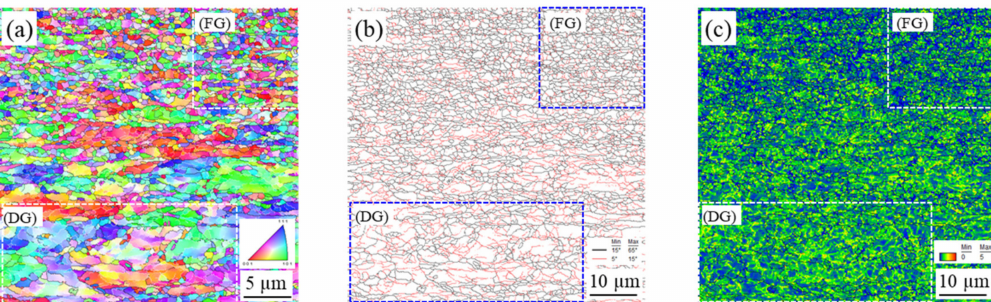
Figure 10. EBSD characterization of the BM: ( a ) inverse pole figure; ( b ) grain boundary; and ( c ) KAM.